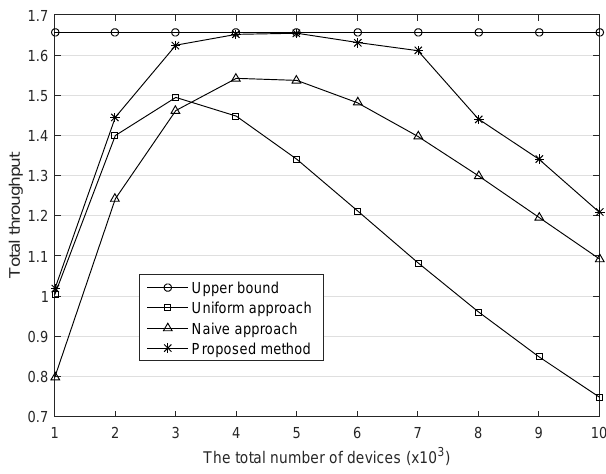
Figure 5. The comparison of the total throughput. The number of channel, N c is 3.